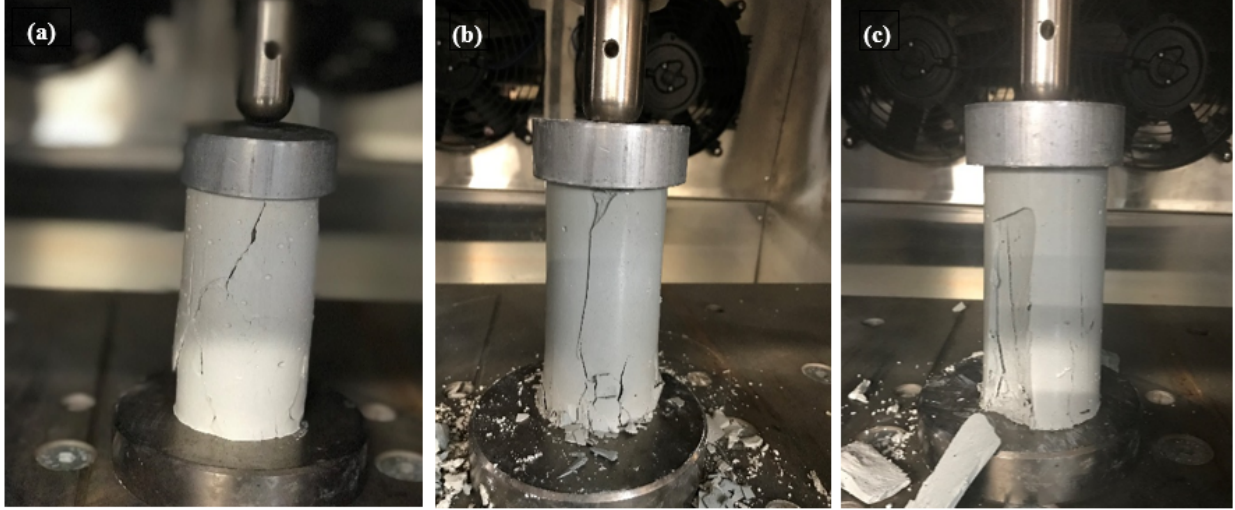
Figure 7. Effects of geopolymer content and A/B ratios on the modulus of elasticity (E 50 ) for kaolin clay at 28 days of curing time.